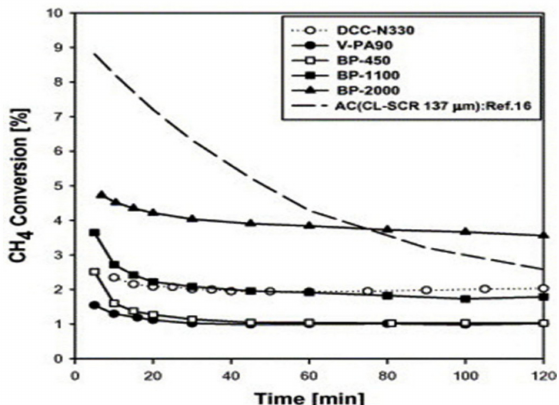
Figure 13. Catalytic performance of the carbonaceous catalysts at 850 ◦ C with trade names CB-N330 (loose black), Vulcan PA90, Black Pearls 450, Black Pearls 1100, Black Pearls 2000, and another activated carbon catalyst, AC (CL-SCR 137); reprinted with permission from ref. [101]. Copyright 2004 Elsevier.